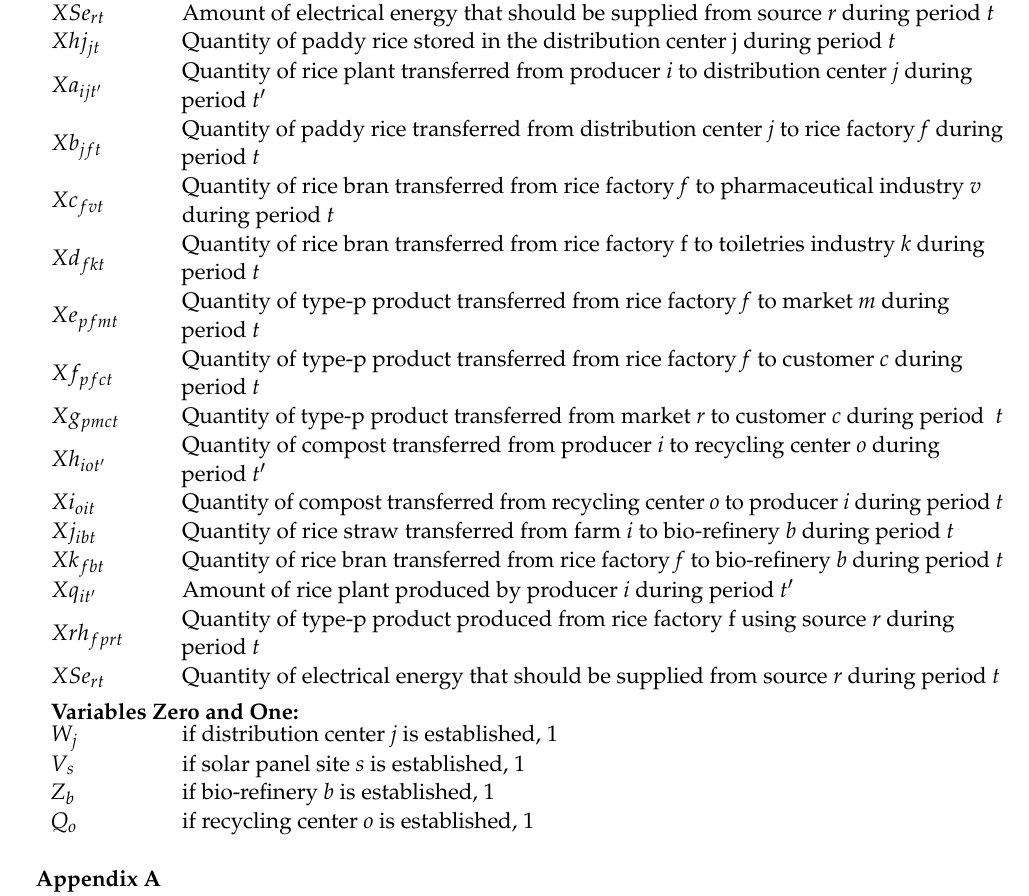
Table A1. The proposed priority-based decoding procedure of segment 2. For t = 1 to T